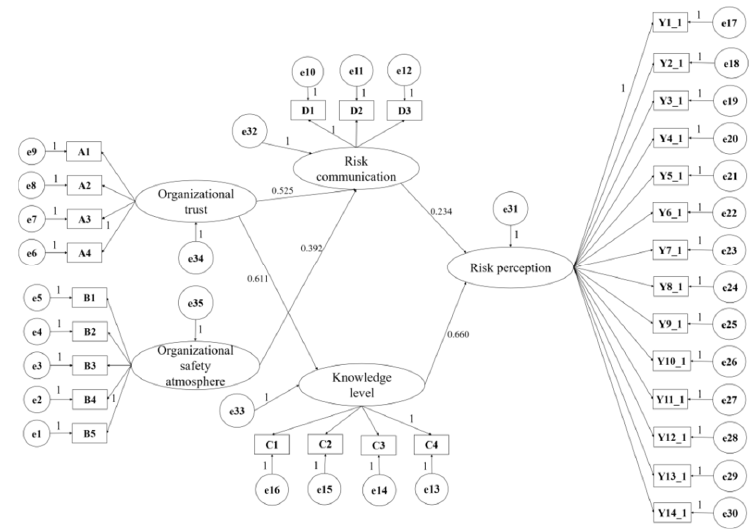
Figure 3. Multi-factor structural model 2 of risk perception level of miners. Table 7. Fitting indicators of model 2.